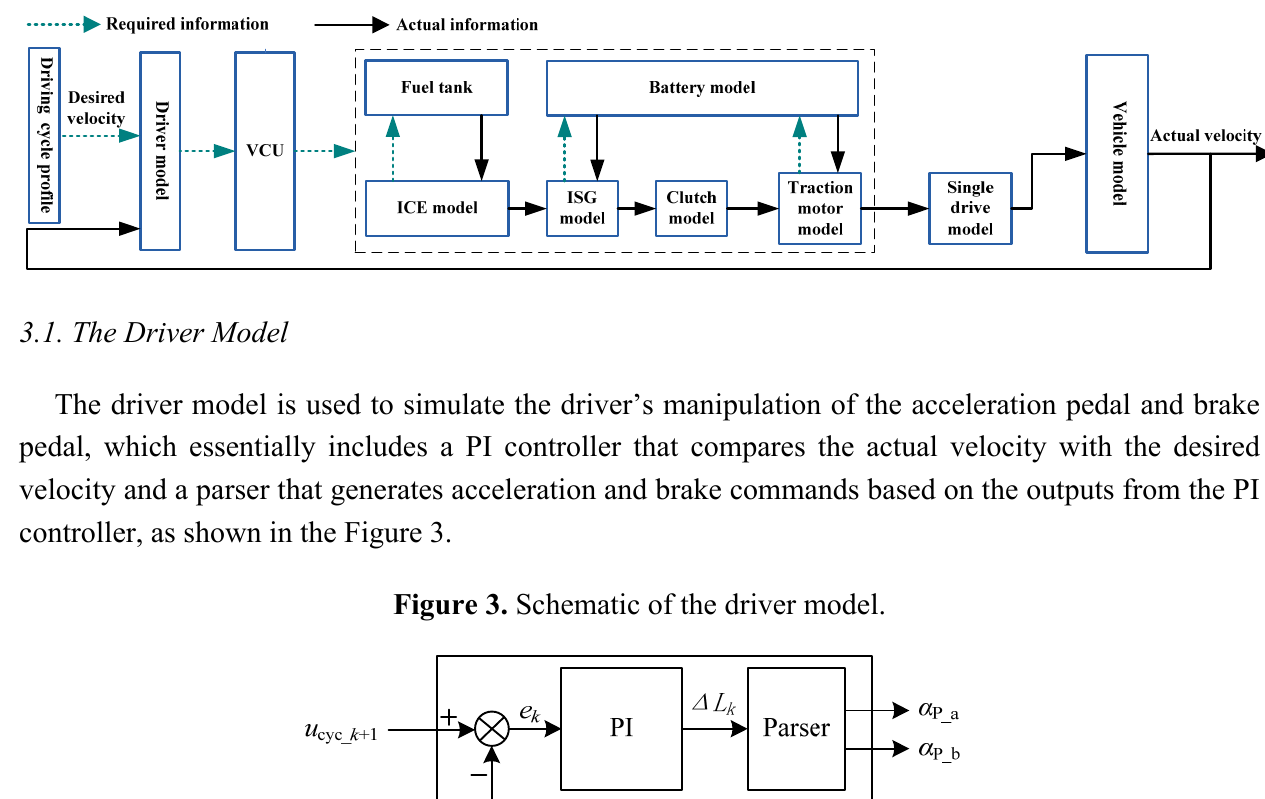
Figure 2. The architecture of the forward-facing quasi-static PHEB model.